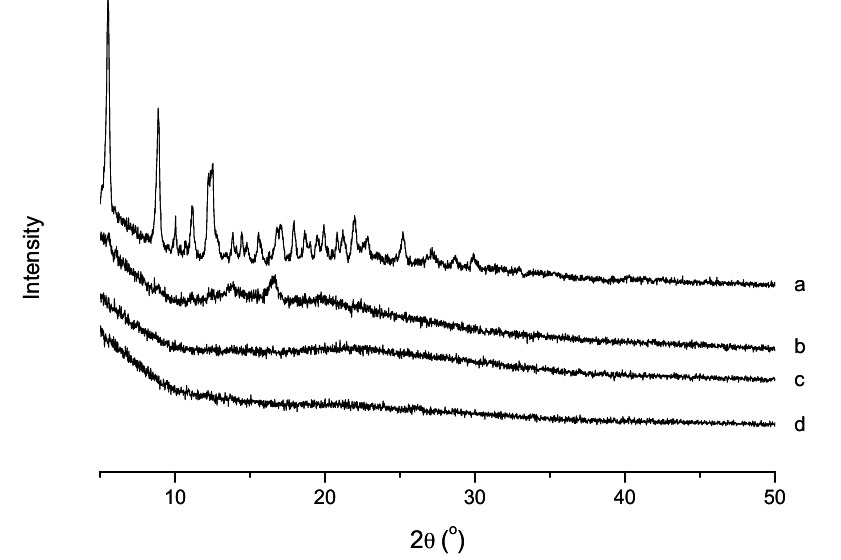
Figure 6. XRD spectra of ( a ) PTX, ( b ) a physical mixture of PTX and blank micelles, ( c ) PTX-loaded micelles and ( d ) blank micelles.